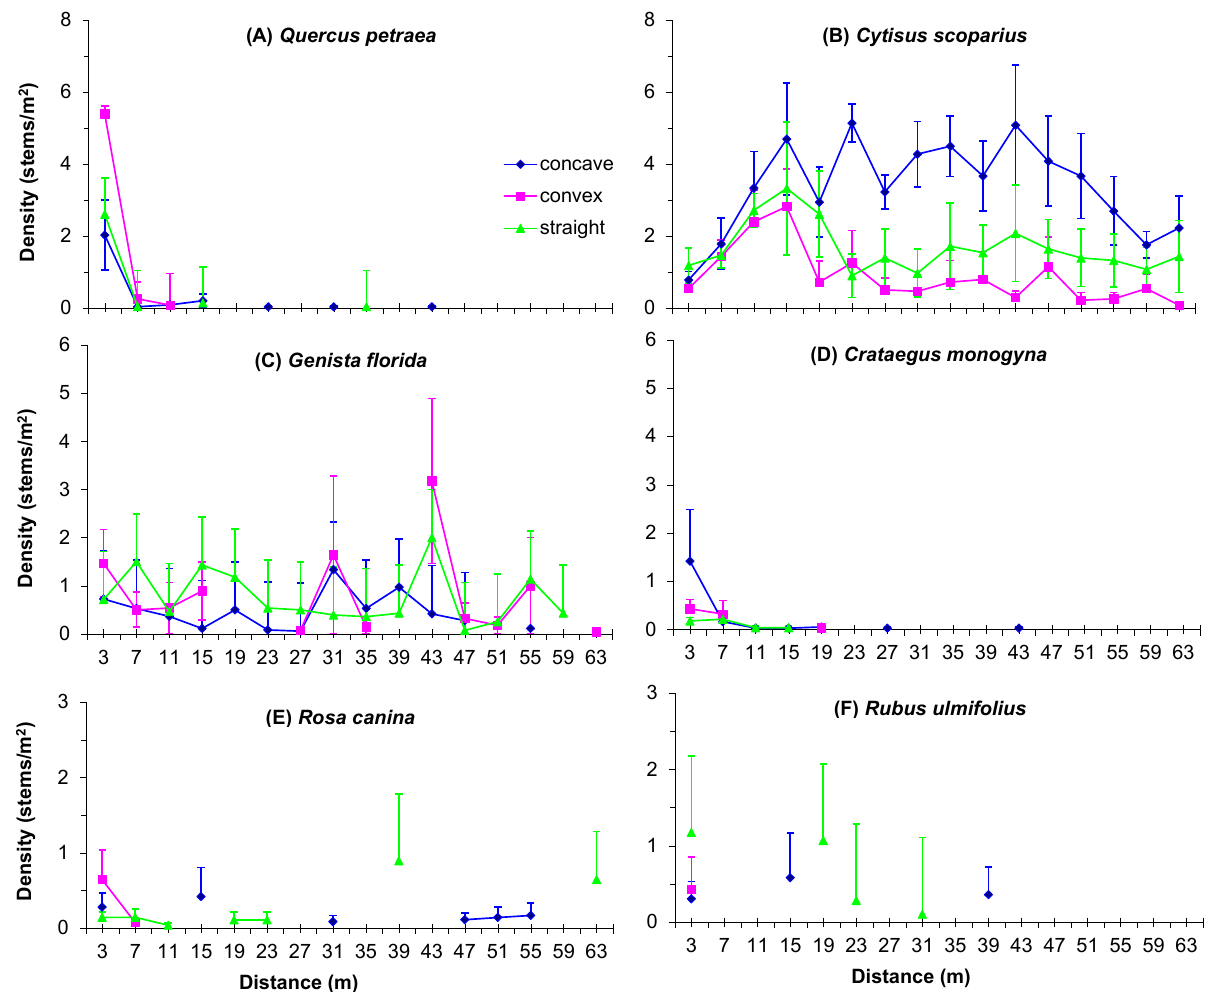
Figure 4. Average woody density (stems/m 2 ) and standard error (SE) of six main woody species ( A − F ) colonizing the mines (those that accounted for more than 2% of all the colonizing stems), according to the distance to the forest edge (m) in the three boundary types (concave, convex, and straight).